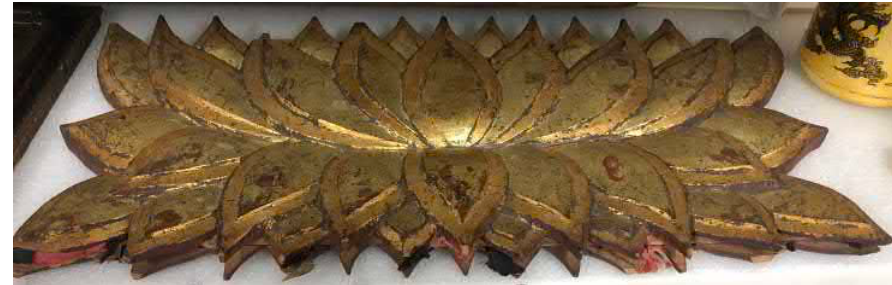
Figure 7: Lotus Flower, Cairns and District Chinese Association. (Photo: Anna